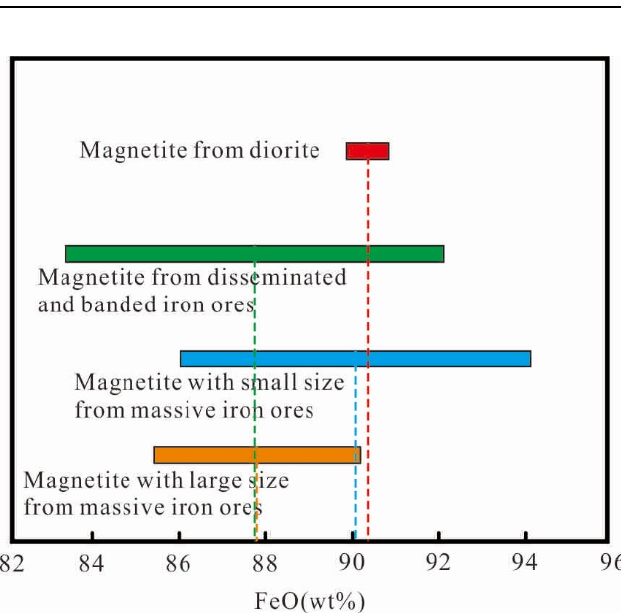
Figure 13. Variation in FeO content from magmatic, disseminated, banded, and massive magnetites from Jinling diorites, skarn, and ore. Table 5. EPMA data for magnetites from Jinling diorites, skarn, and ore.